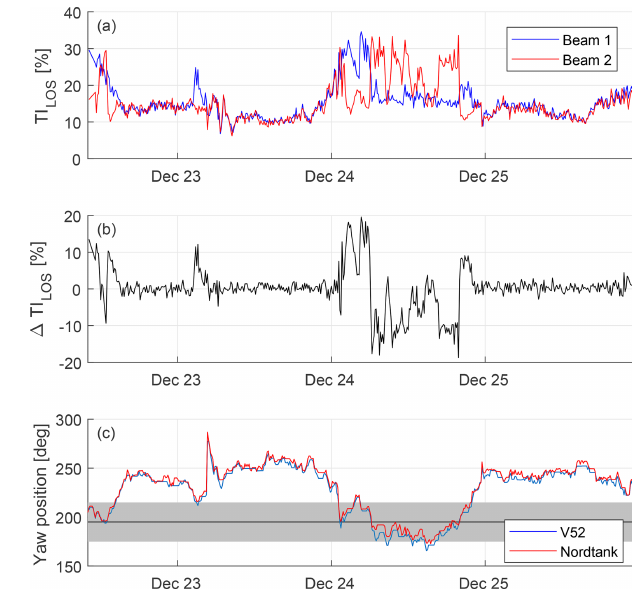
Figure 7. Example time series of TI LOS (a) , (cid:49) TI LOS (b) and the yaw positions of the two turbines (c) . The black horizontal line and the grey shading in the bottom plot indicate the wake position (i.e. 195 ◦ ) and a band of 195 ◦ ± 20 ◦ , respectively.